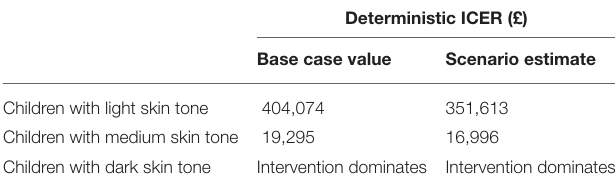
TABLE 10 | Scenario analysis assuming lifelong